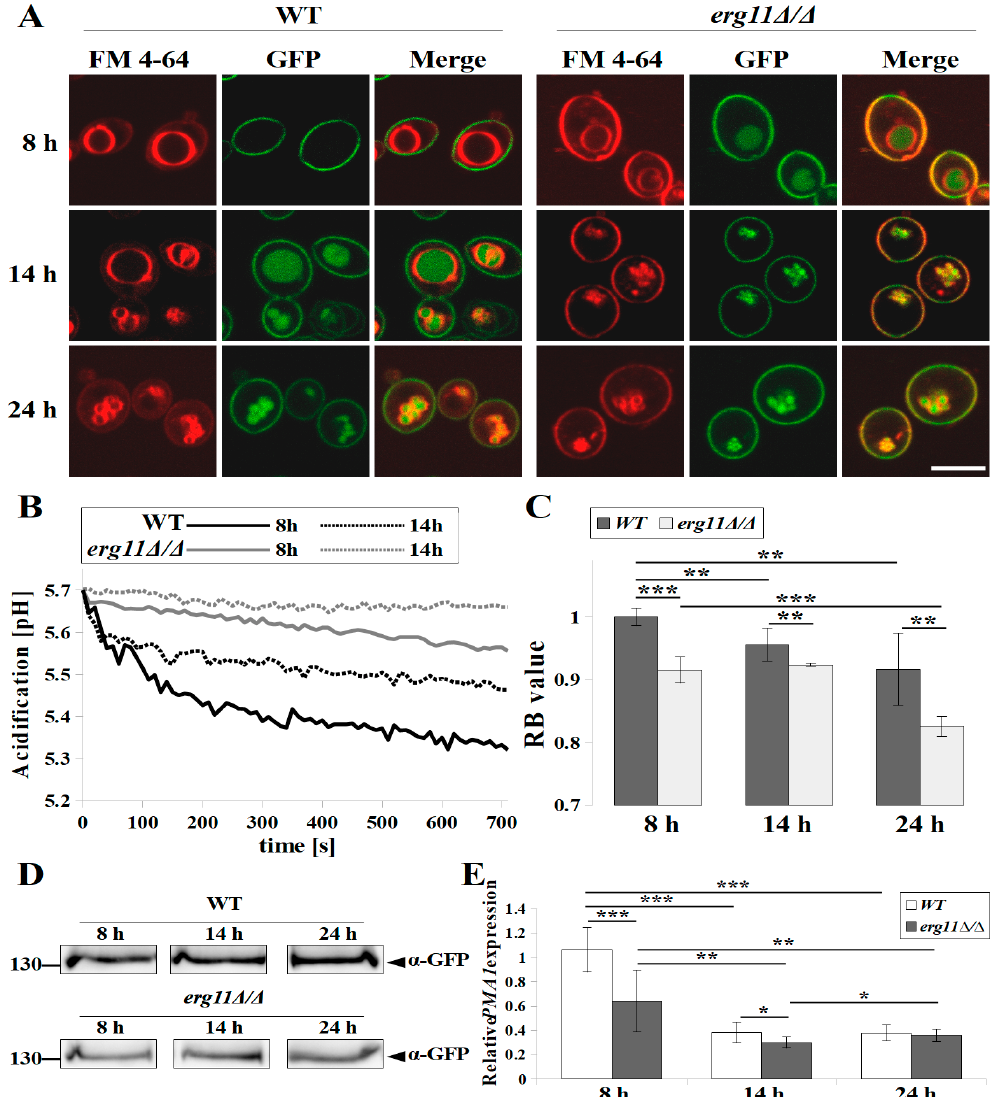
Figure 3. ( A ) Confocal micrographs of vacuolar membrane staining (FM 4-64) and subcellular localization of Pma1-GFP protein in C. albicans YHXW11 and KS045 ( PMA1-GFP, erg11 ∆ / ∆ ) strains during growth (8, 14, and 24 h). A merged image of the GFP-tagged protein and FM 4-64 staining is shown in the third column. Scale bar = 5 µ m. ( B ) Activity of Pma1p in C. albicans CAF2-1 (WT, black lines) and KS028 ( erg11 ∆ / ∆ , grey lines) strains after 8 h (solid lines) and 14 h (dashed lines) growth, expressed as acidification in time (0–720 s). Graphs are representative of three independent assays. ( C ) Plasma membrane potential ( ∆Ψ ) expressed as RB values (means ± SD, n = 9) calculated from fluorescence spectra of di-4-ANEPPS incorporated into plasma membranes of C. albicans CAF2-1 (WT) and KS028 ( erg11 ∆ / ∆ ) strains. ( D ) Immunoblot analysis of Pma1-GFP p levels in C. albicans YHXW11 (WT) and KS045 (PMA1-GFP , erg11 ∆ / ∆ ) strains during growth (8, 14, and 24 h). The samples were resolved on 10% SDS-PAGE gel and probed by an anti-GFP antibody. Ponceau S staining was used as the loading control. Experiment is a representative of three independent assays and the presented conditions were resolved in the same gel and cut out into separate lines (Figure S3A). ( E ) Relative PMA1 gene expression in WT (CAF2-1) and KS028 ( erg11 ∆ / ∆ ) strains during growth (8, 14, and 24 h). Gene expression levels as means of 2 −∆∆ CT values ( n = 6) ± SD; normalised to 1 for 8 h WT gene expression level. Statistical analysis in ( C ) and ( E ) compared data during different growth phases, and between C. albicans WT and KS028 ( erg11 ∆ / ∆ ) strains (*, p < 0.05; **, p < 0.01; ***, p < 0.001).